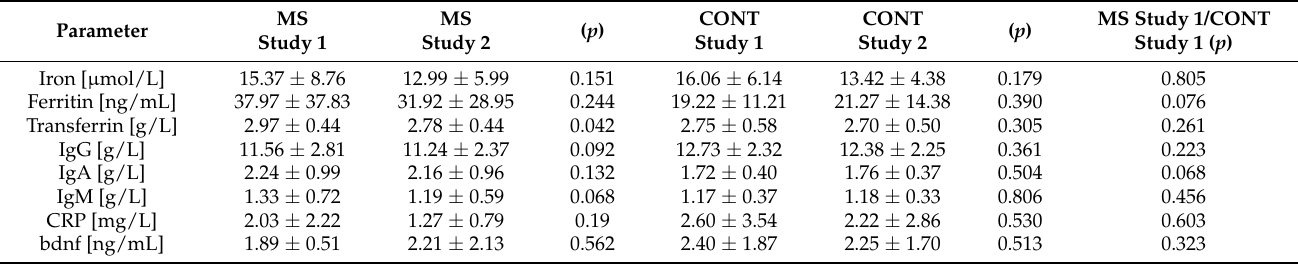
Table 2. The iron status, biochemical parameters and biomarkers of neuroplasticity in the experimen- tal group (MS) and in the control group (CONT) before the intervention sessions (Study 1) and after the intervention sessions (Study